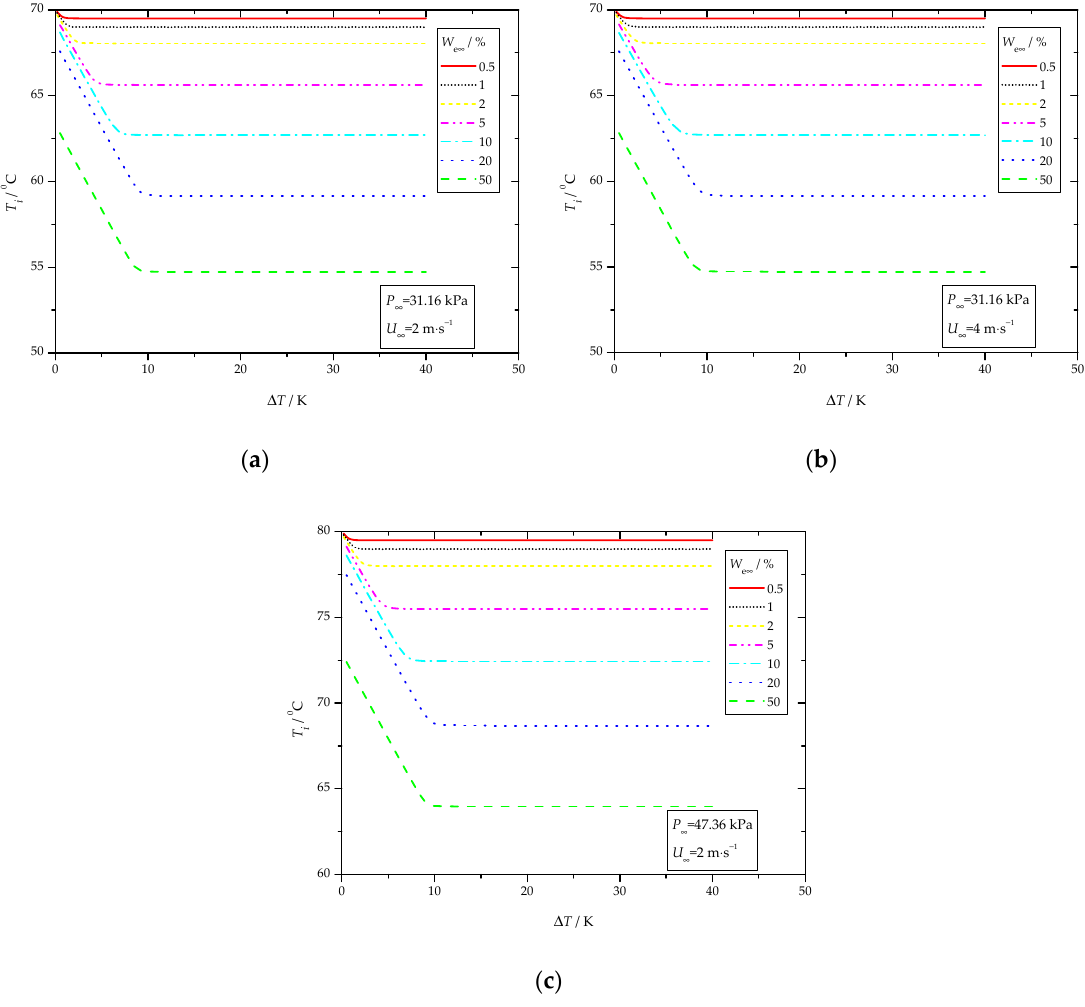
Figure 3. Calculation results of vapor-liquid interface temperatures at ( a ) P ∞ = 31.16 kPa, U ∞ = 2 m · s − 1 ; ( b ) P ∞ = 31.16 kPa, U ∞ = 4 m · s − 1 ; ( c ) P ∞ = 47.36 kPa, U ∞ = 2 m · s − 1 .